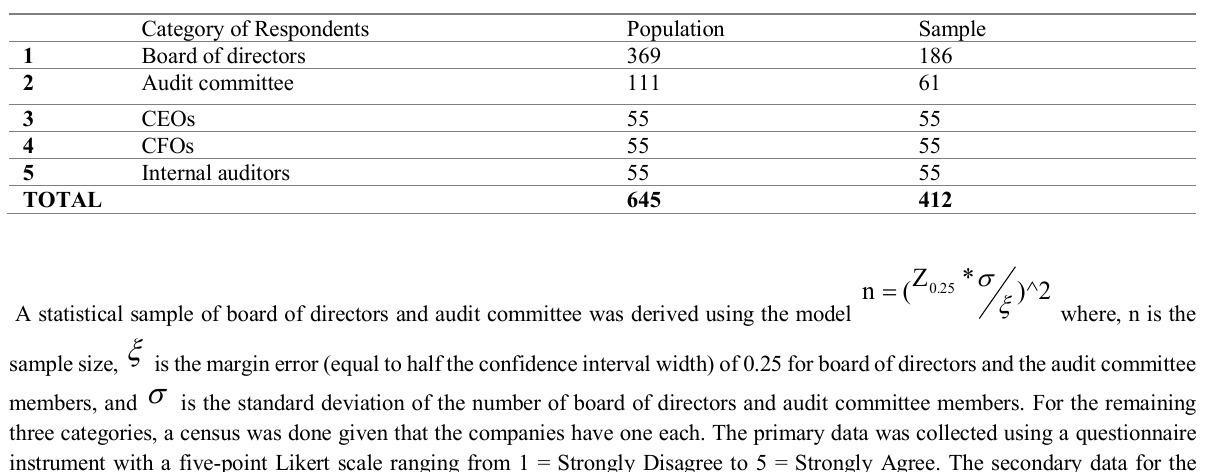
Table 1: Population and Sample